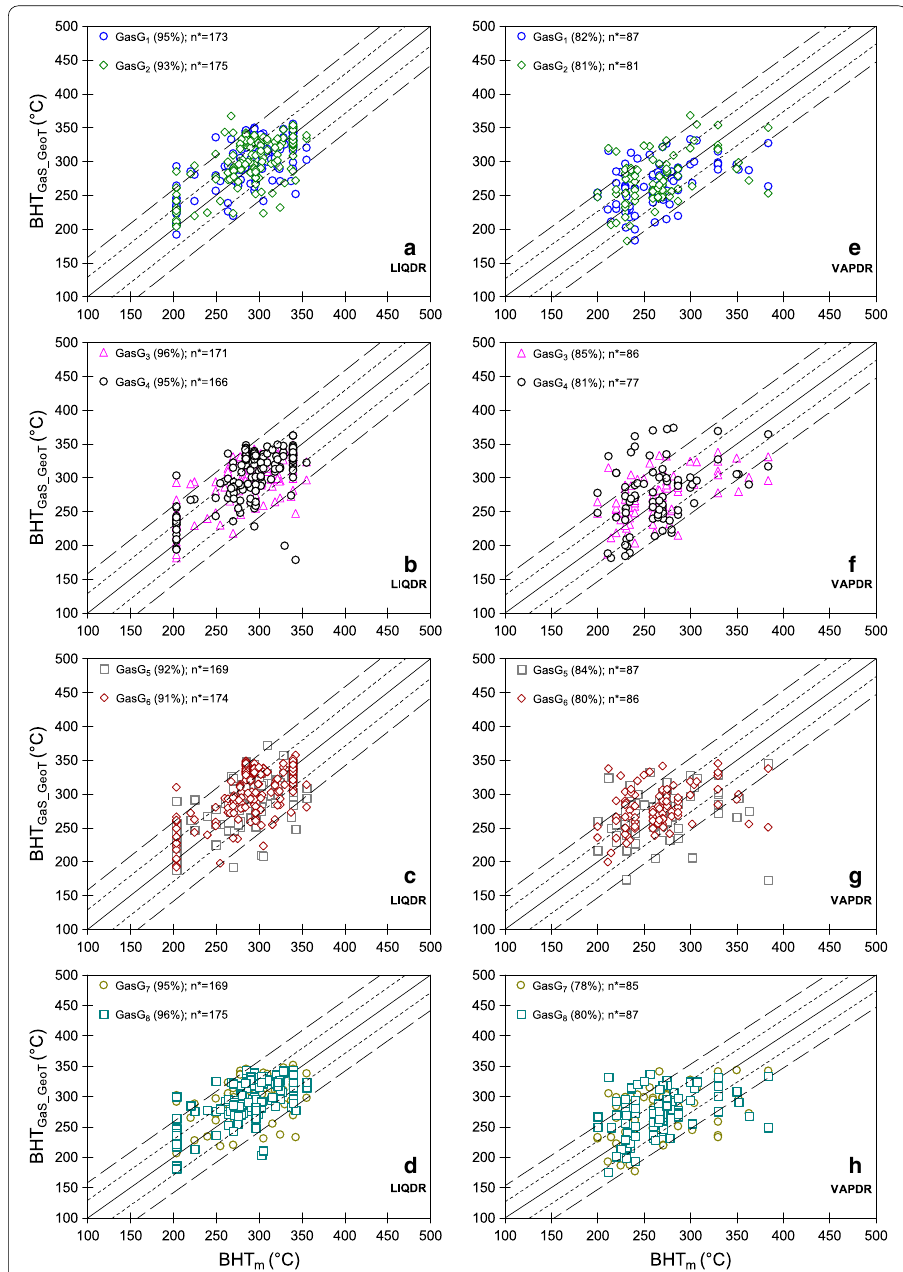
Fig. 5 Results of a comparative analysis between measured (BHT m ) and temperature estimates calculated for the new gas geothermometers (BHT GaS_GeoT ). The plots a – d show the temperature results predicted by the new geothermometers for LIQDR wells, whereas the plots e – h ] show the results for VAPDR. n* is the number of samples that fulfil the applicability conditions of each new gas geothermometer (Table 8). Dotted and dashed lines represent a hypothetical variability of the